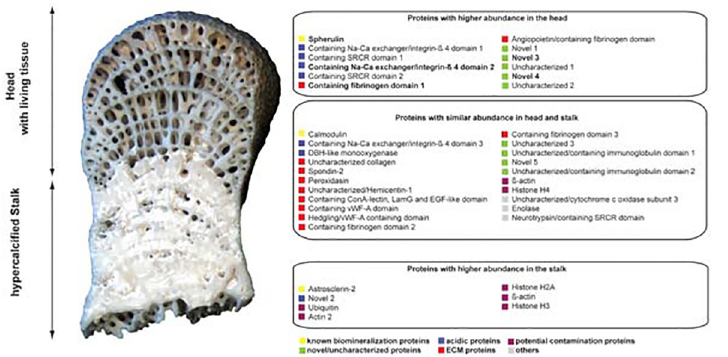
Fig 4. Schematic representation of Vaceletia sp . head and stalk region with iBAQ estimates of protein abundances. 12 proteins are enriched in the head, while 7 proteins are enriched in the stalk and 21 proteins have an equal abundance in head and stalk. Protein abundances were considered as different when iBAQ estimations between head and stalk were (cid:1) 0.5. Proteins in bold were only detected in the head